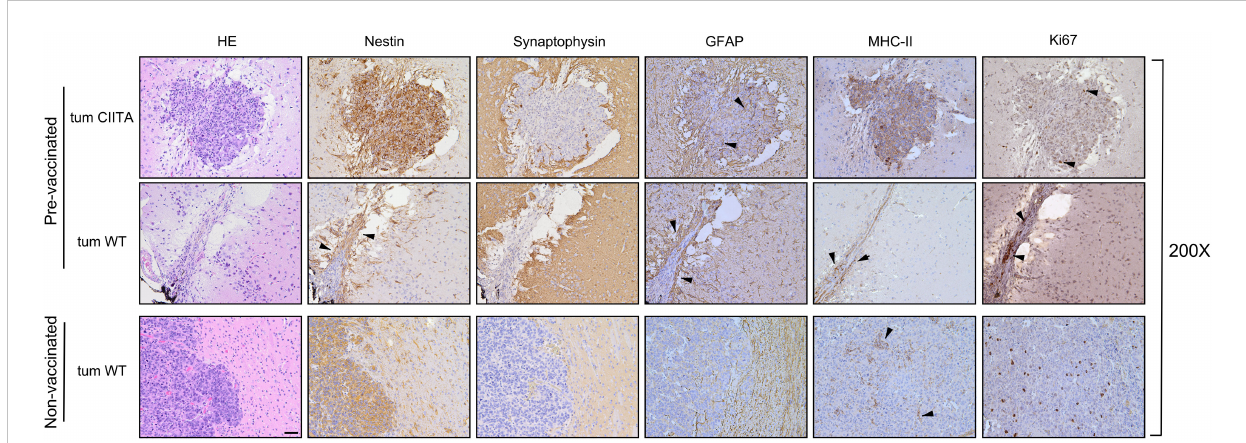
FIGURE 6 Immunohistological characterization of GL261 tumor rejection in GL261-CIITA pre-vaccinated mice. Representative histological sections of tumor tissues harvested from pre-vaccinated (upper panels, tum CIITA and tum WT) and non-vaccinated (bottom panels, tum WT) mice, at ×200 magni fi cation; scale bar corresponds to 50 m M. HE was followed by immunohistochemical staining with nestin- and synaptophysin-speci fi c antibodies to better identify tumoral and non-tumoral tissue, respectively. Arrowheads in the panel showing nestin staining of GL261 tumors in pre- vaccinated mice point to astrocytosis-enriched areas. MHC-II expression was speci fi cally observed on GL261-CIITA tumor cells (pre-vaccinated, tum CIITA) and myeloid cells dispersed over the tumor bed at the site of GL261 tumor injection (pre-vaccinated, tum WT, black arrowheads) or dispersed along the GL261 tumor (non-vaccinated, tum WT, black arrowheads). Marked GFAP-positive astrocytosis was found on GL261-CIITA tumors (pre- vaccinated, tum CIITA, black arrowheads). GFAP is also markedly expressed and distributed around the tumor bed in the left striatum (pre- vaccinated, tum WT, black arrowheads). Ki67-positive cells are abundant in tumors isolated from non-vaccinated mice and decreased in GL261- CIITA tumors (pre-vaccinated, tum CIITA, black arrowheads) or markedly expressed by lymphocytes and fi broblasts over the tumor bed in the right striatum (pre-vaccinated, tum WT, black arrowheads). HE, hematoxylin and eosin; GFAP, glial fi brillary acidic